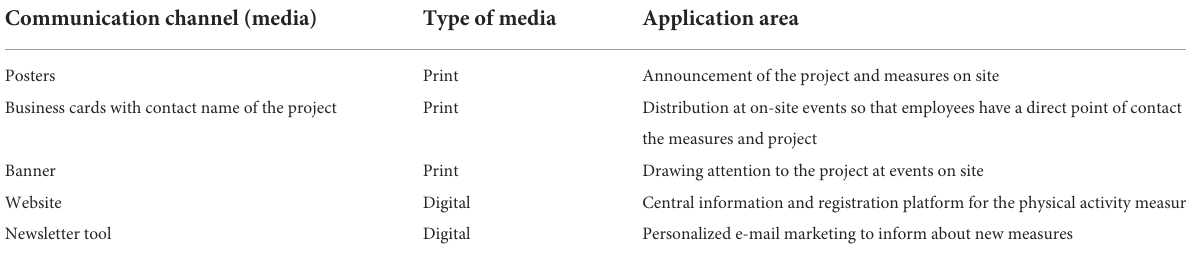
TABLE 1 Communication channels within the KomRueBer